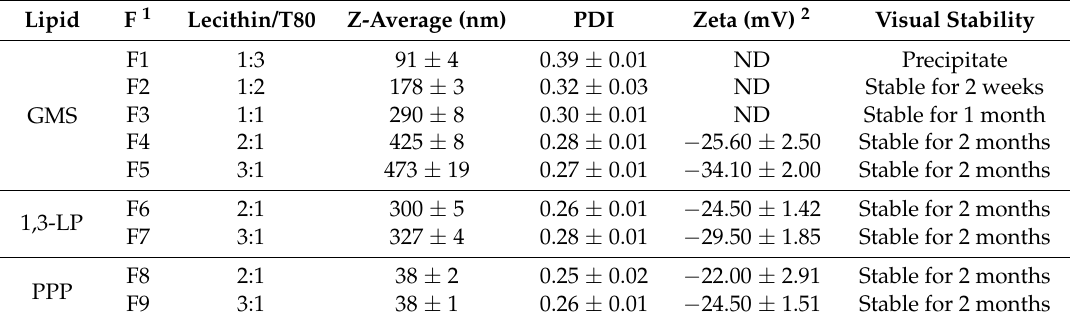
Table 1. The Z-average mean diameter (Z-average), PDI, zeta-potential (Zeta), and storage stability (at 25 ◦ C for up to two months) of SLN dispersions prepared with three types of lipids using different mass ratios of lecithin and T80. All samples were prepared with 80 mg lipid, 240 mg surfactants, 2 g double distilled water, and 0.5 mL ethanol.